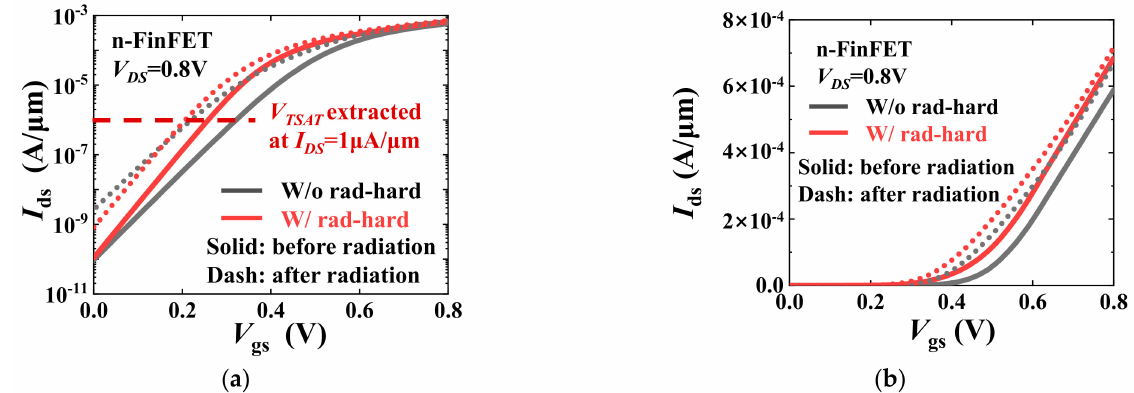
Figure 4. Comparison of the ( a ) log scale and ( b ) linear scale transfer characteristics’ drift caused by the total dose radiation in SOI n-FinFETs with and without reinforcement. Table 3. Simulated electrical characteristics of 14 nm node SOI FinFETs with various designs and radiation conditions.